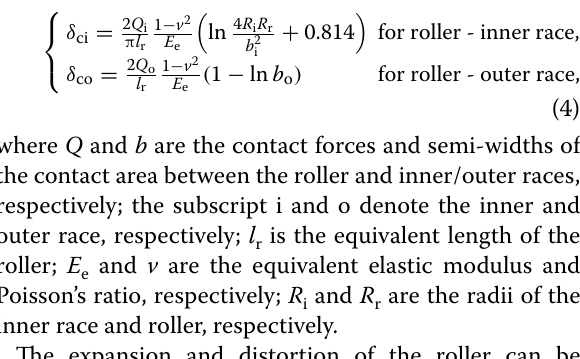
be respectively expressed as [31]